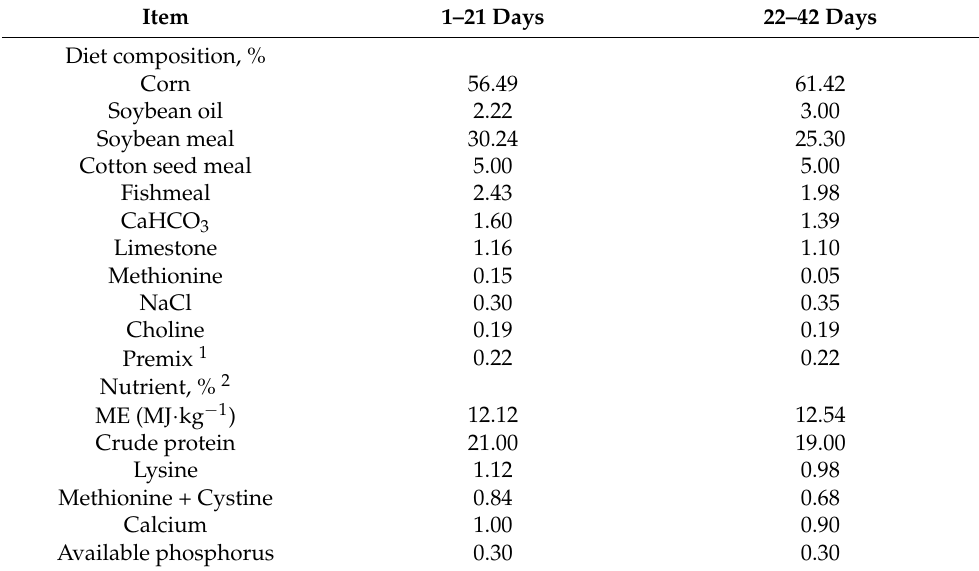
Table 1. Composition of and nutrient levels in the basic